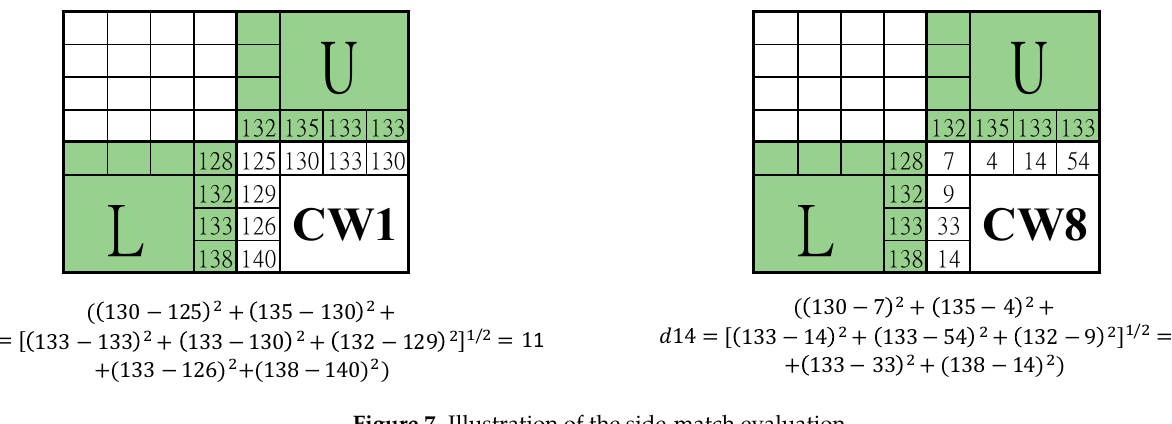
Figure 7. Illustration of the side-match evaluation.